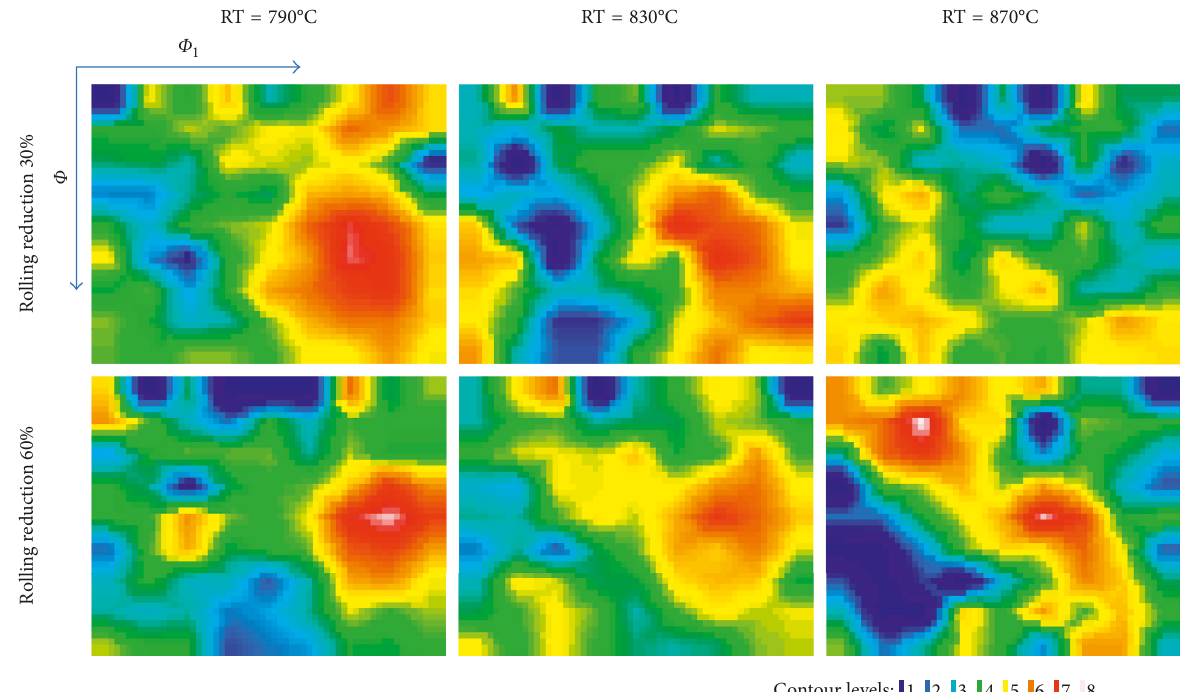
Figure 4: Orientation distribution function of warm rolled steels at different thermomechanical conditions at Φ